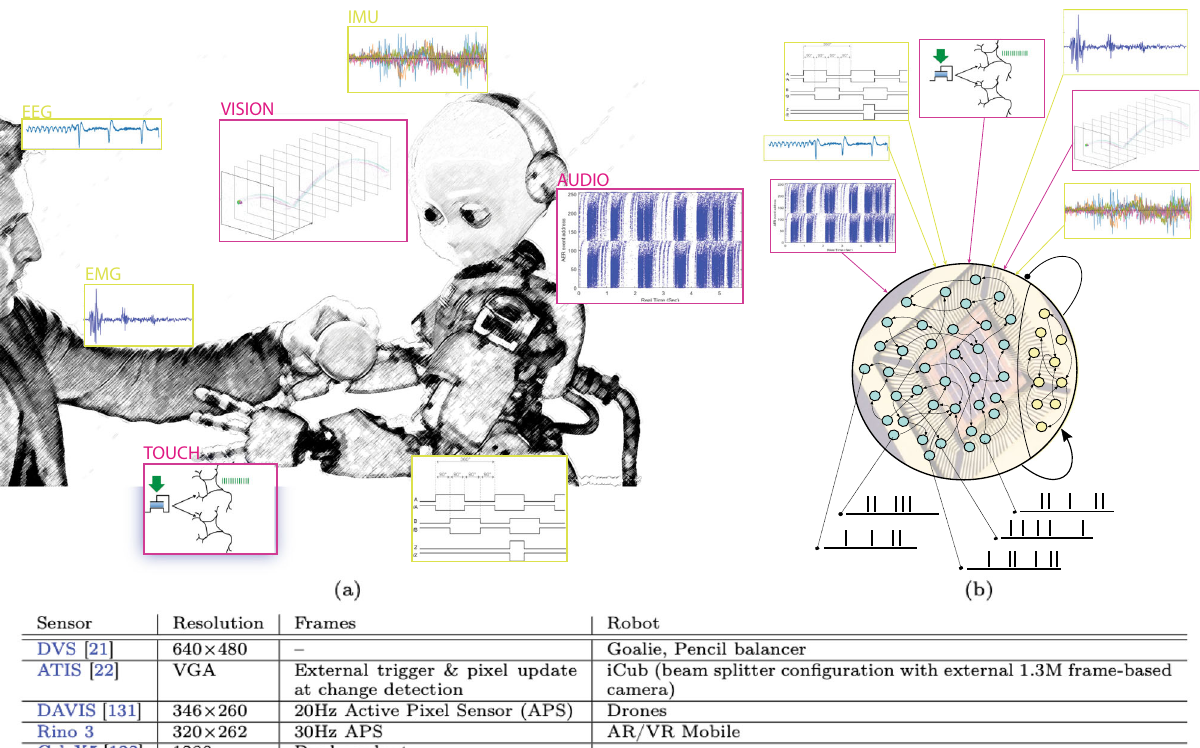
Fig. 2 Neuromorphic sensing for robots. a the iCub robot (picture © IIT author Duilio Farina) is a platform for integrating neuromorphic sensors. Magenta boxes show neuromorphic sensors that acquire continuous physical signals and encode them in spike trains (vision, audition, touch). All other sensors, that monitor the state of the robot and of its collaborators, rely on clocked acquisition (green boxes), that can be converted to spike encoding by means of Field Programmable Gate Arrays (FPGAs) or sub-threshold mixed-mode devices. b The output of event-driven sensors can be sent to Spiking Neural Networks (SNNs) (with learning and recurrent connections) for processing. VISION box in ( a ): Event-driven vision sensors produce “ streams of events ” (green for light to dark changes, magenta for dark to light changes). The trajectory of a bouncing ball can be observed continuously over space, with microsecond temporal resolution (black rectangles represent sampling of a 30 fps camera). Table: Event-driven vision sensors evolved from the Dynamic Vision Sensor (DVS) with only “ change detecting ” pixels - to higher resolution versions with absolute light intensity measurements. The Dynamic and Active pixel VIsion Sensor (DAVIS) 131 acquires intensity frames at low frame rate simultaneously to the “ change detection ” (with minor cross talk and artefacts on the event stream during the frame trigger). The Asynchronous Temporal Imaging Sensor (ATIS) 132 samples absolute light intensity only for those pixels that detect a change. The CeleX5 offers either frame-based or event-driven readout (with a few milliseconds delay between the two, resulting in loss of event stream data during a frame acquisition). Similar to the DAVIS, the Rino3 captures events and intensity frames simultaneously, however, it employs a synchronised readout architecture as opposed to the asynchronous readout typically found in other event-driven sensors. The ultimate solution combining frames and events is yet to be found. Merging two stand-alone sensors in a single optical setup poses severe challenges in terms of the development of optics that trade-off luminosity with bulkiness. Merging two types of acquisition on the same sensor limits the fi ll-in factor and increases noise and interference between frames and